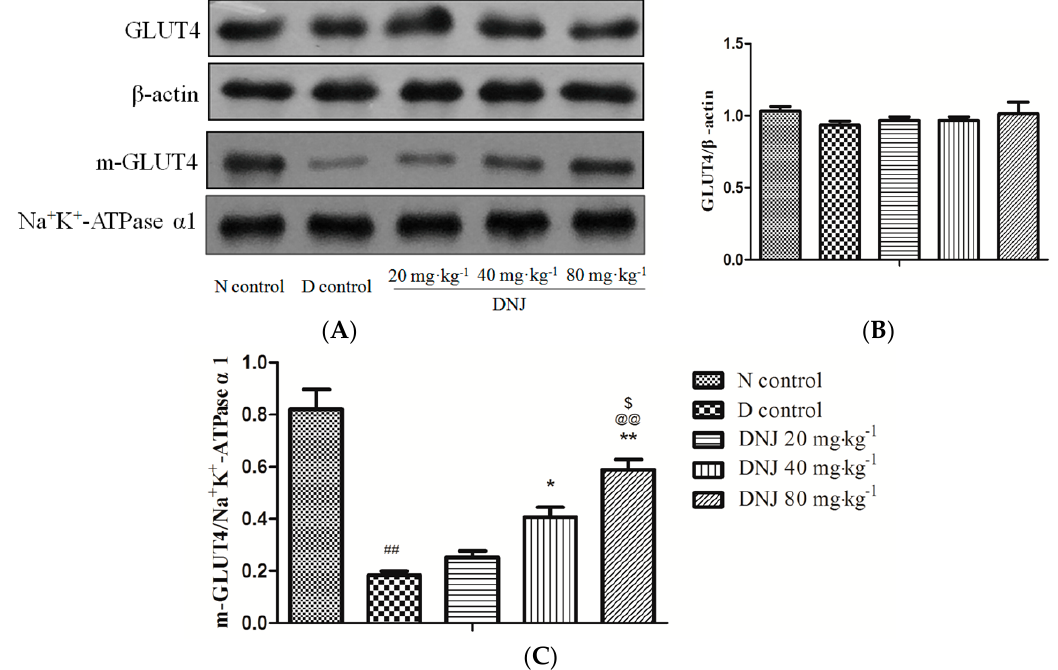
Figure 6. Effects of DNJ on GLUT4 expression and translocation in db/db mice. Western blot analysis for GLUT4 and m-GLUT4 protein expression in skeletal muscle of db/db mice ( A ). Expression ratio of GLUT4 ( B ) and m-GLUT4 ( C ) were analyzed. These data were representative of three independent experiments. The GLUT4 protein was normalized by β -actin and the m-GLUT4 was normalized by Na + K + -ATPase α 1. ## p < 0.01 vs. N control; * p < 0.05, ** p < 0.01 vs. D control; @@ p < 0.01 vs. DNJ